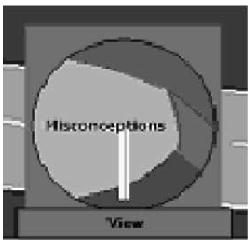
Figure 4. The aircraft positioning view presenting a